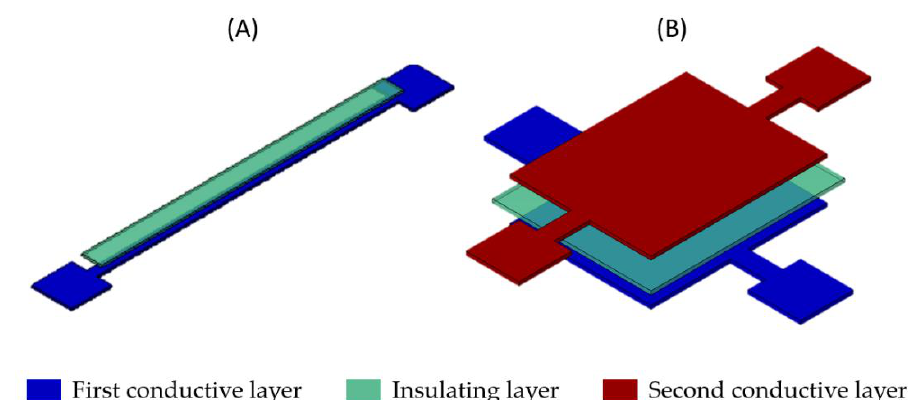
Figure 2. Schematic 3D view of two designs: ( A ) For the characterization of the ink conductivity and the tests of bending radius ( B ) For the characterization of the dielectric constant of the UV insulating ink.